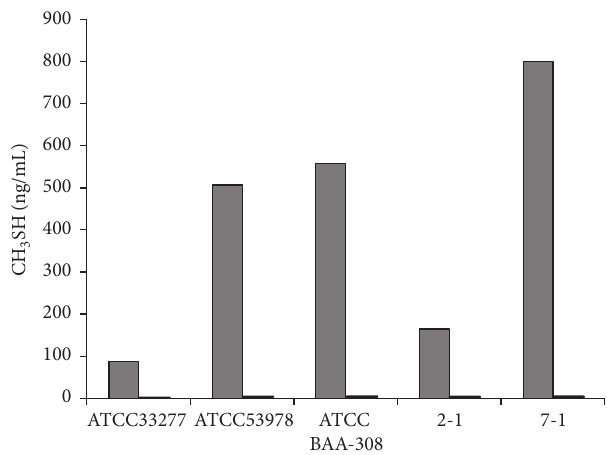
Figure 3: The levels of CH 3 SH in spent medium from P. gingivalis cultured for 48h in the presence or absence of E. faecium WB2000 (ng/mL). Grey bars: single culture; white bars: dual culture with E. faecium